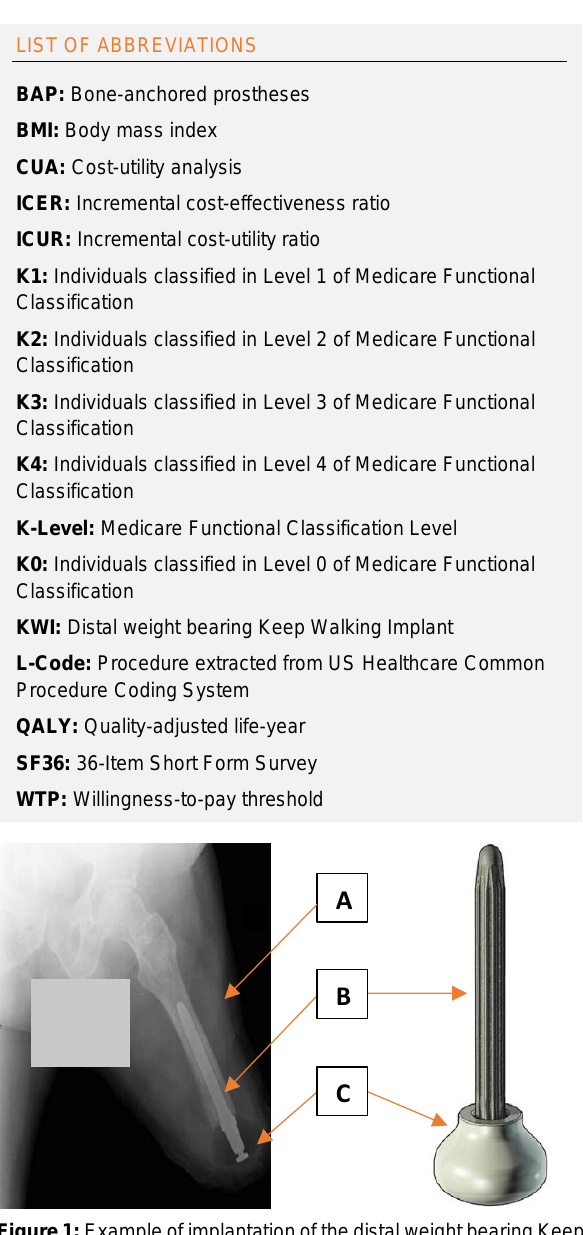
Figure 1: Example of implantation of the distal weight bearing Keep Walking Implant in the transfemoral residuum (A) including and endomedullar femoral stem (B) and rounded spacer (C) that reshaping the distal end of the residuum with a more uniform cone facilitating direct transmission of loading and, altogether, improving safely quality of life and walking ability .